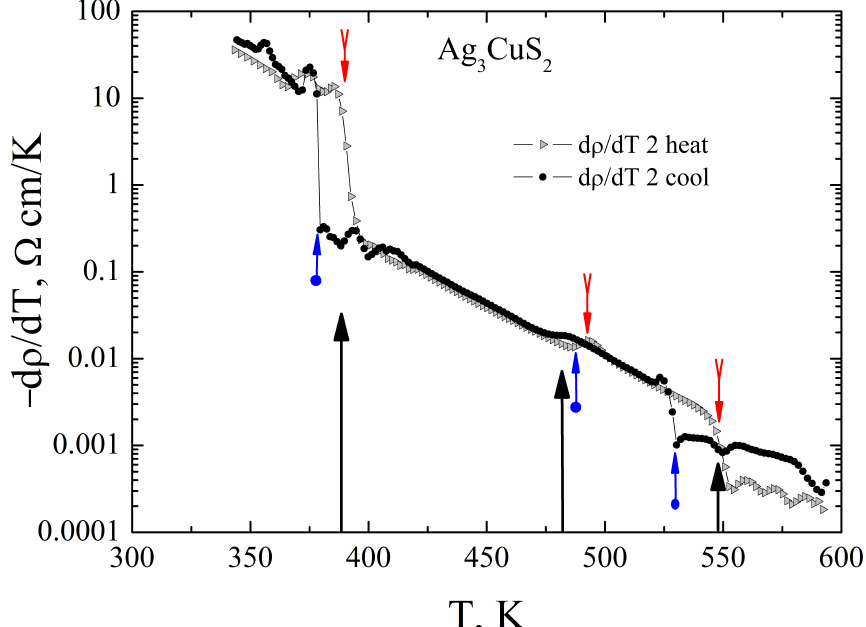
Figure 5. Temperature derivative of the resistivity of Ag 3 CuS 2 on the second heating-cooling cycle. The large arrows indicate temperatures of the structural phase transitions according to Ref. [11]. The small downward pointing arrows indicate the on-heating temperature of the transition, while the upward pointing arrows show the on-cooling transition temperature according to the resistivity data.